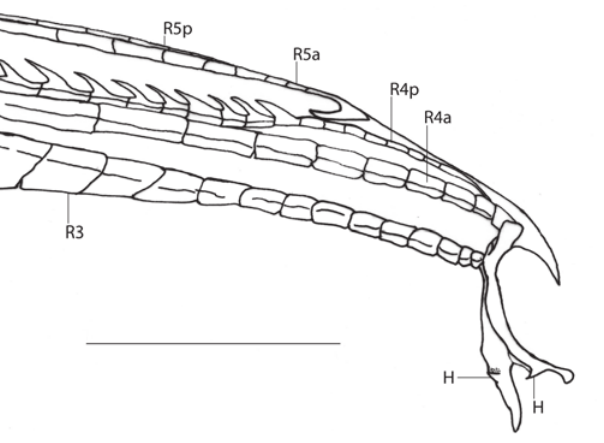
Fig. 28. Gonopodium tip of Phalloceros harpagos , MCP 20569. R3, R4a, R4p, R5a, R5p indicate gonopodial rays. Scale bar 1 mm.